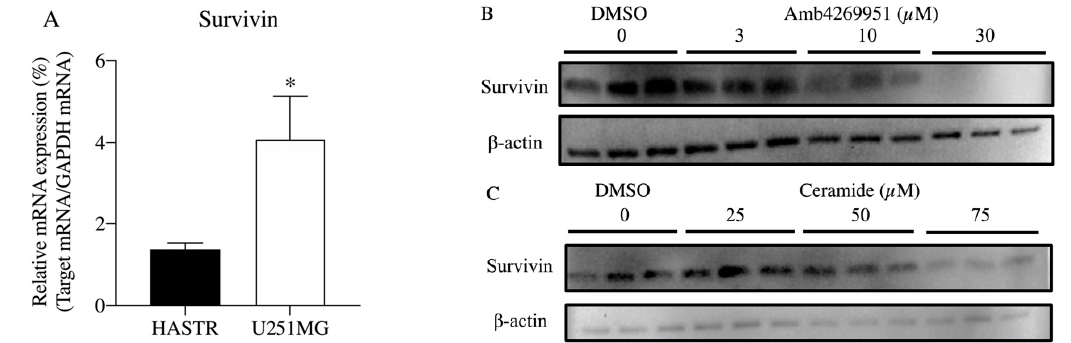
Figure 6. Effect of Amb4269951 and ceramide on the mRNA expression of survivin in U251MG cells. ( A ) Real-time PCR analysis of the mRNA expression of survivin in HASTR/ci35 and U251MG cells. The percentage of relative mRNA expression is expressed as the ratio of the target mRNA to the GAPDH mRNA. Each column represents the mean ± SD ( n = 3). * p < 0.05 compared to the HASTR. ( B ) Effect of Amb4269951 on the expression of survivin in U251MG cells. Cells were incubated with various concentrations of Amb4269951 for 24 h. Western blot analysis shows survivin and ß-actin levels in whole cell lysates of drug-treated U251MG cells. The experiment was performed in triplicate. ( C ) The effect of ceramide on the expression of survivin in U251MG cells. Cells were incubated with various concentrations of Amb4269951 for 24 h. Western blot analysis shows survivin and ß-actin levels in whole cell lysates of drug-treated U251MG cells. The experiment was performed in triplicate.